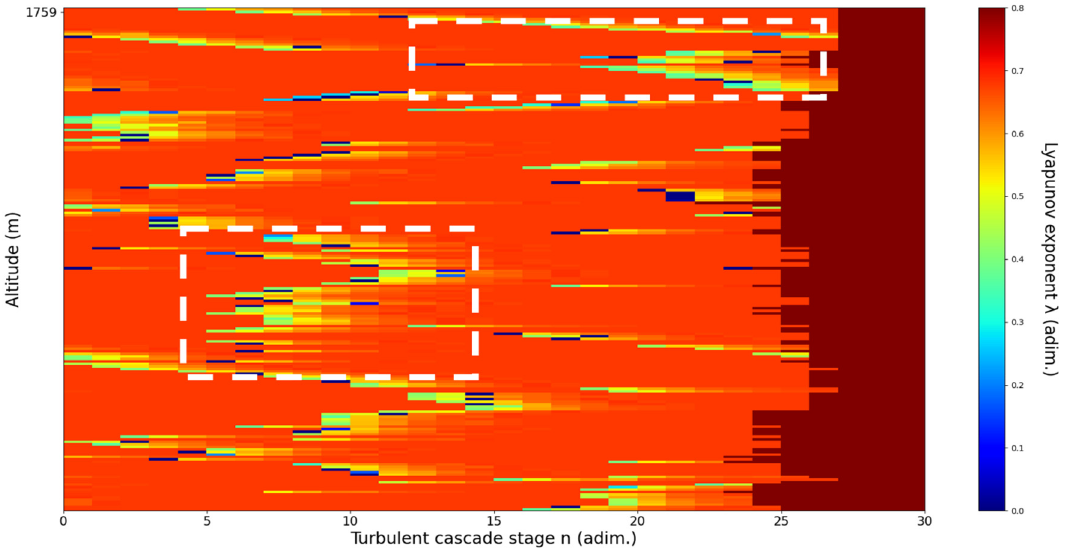
Figure 24. Lyapunov exponent per turbulent cascade stage colormap altitude plot, Bucharest, Romania, 13 June 2019,